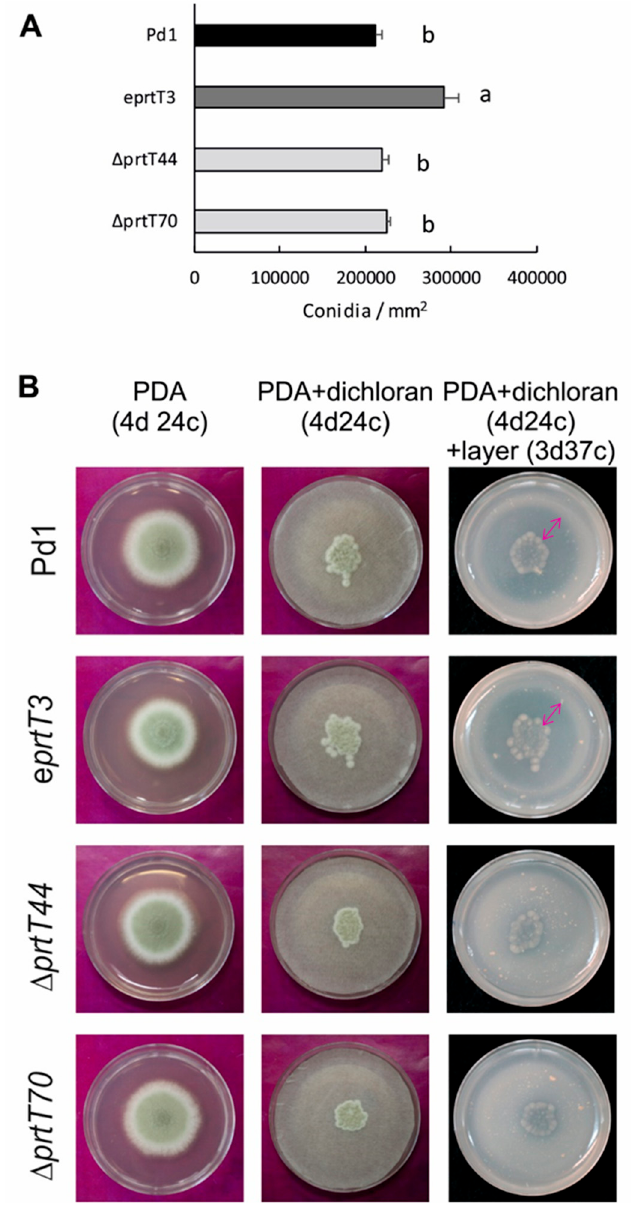
Figure 2. Phenotypic analysis of the Δ prtT mutants. ( A ) Conidia production per colony area (in mm 2 ) of the parental strain Pd1, the ectopic e prtT 3 mutant, and the two knockout mutants Δ prtT 44 and Δ prtT 70. Strains were grown on PDA plates and the conidia were collected and countered after 7 days at 24 °C. Error bars indicate the standard deviation of at least three biological replicates. Different letters indicate statistically significant differences among strains at p < 0.05. ( B ) Colony view of the parental strain Pd1, the ectopic e prtT 3 mutant, and the two knockout Δ prtT 44 and Δ prtT 70 mutants after growing on PDA during 4 days at 24 °C, or on PDA containing dichloran during 4 days at 24 °C, or on PDA + dichloran during 4 days at 24 °C followed by a 3 day incubation at 37 °C after adding an agarose layer containing skim milk. The Δ prtT mutants formed a reduced proteolytic halo (indicated with an arrow) on skim milk media.